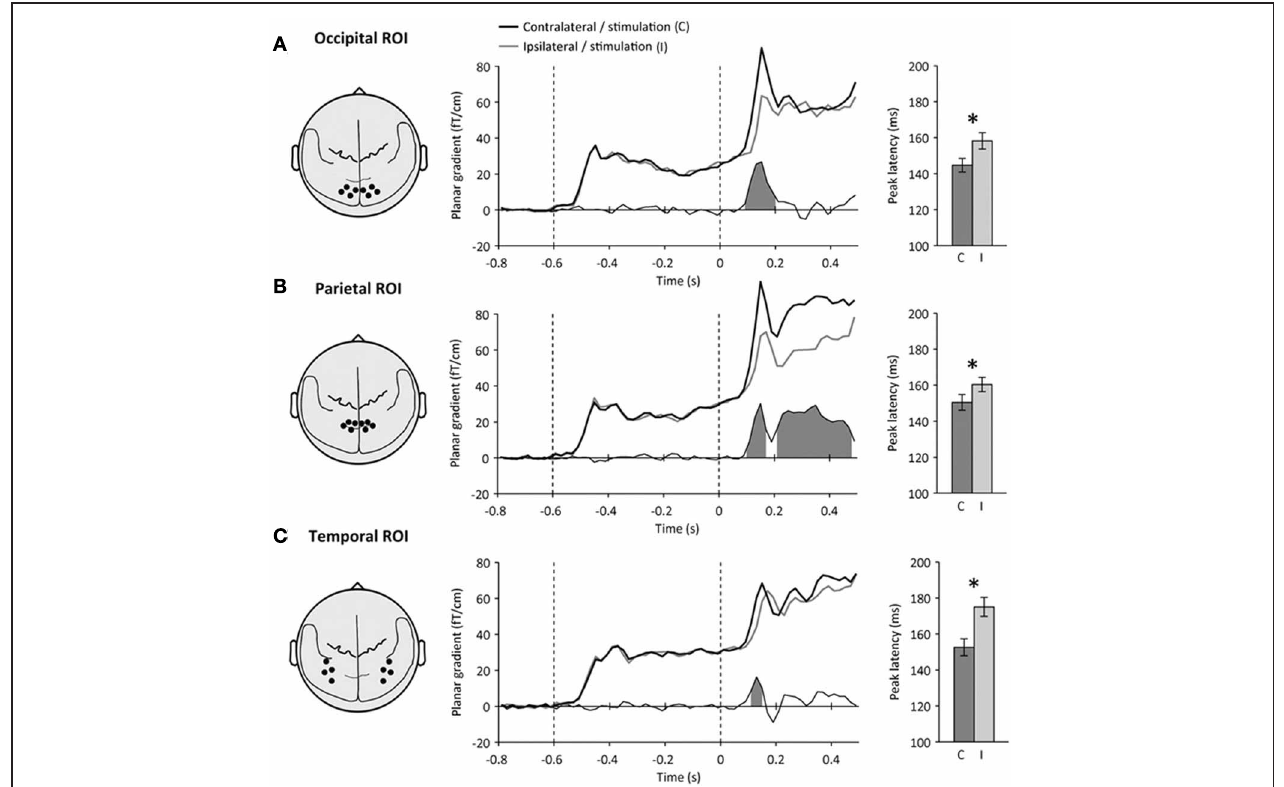
FIGURE 2 | Definition of regions-of-interest. Left: Schematic top view of the head showing the location of each sensor-space region-of-interest (ROI) with respect to the major anatomical landmarks of the brain. Middle: Time course of neuromagnetic event-related signals contralateral (black) and ipsilateral (gray) to visual stimulation at each ROI. Time is expressed relative to target onset (mask onset: + 50ms). The difference between contralateral and ipsilateral signals is shown below. Shaded areas indicate significant amplitude differences ( p < 0 . 05). Right: peak latencies of neuromagnetic signals contralateral (C, dark) and ipsilateral (I, light) to